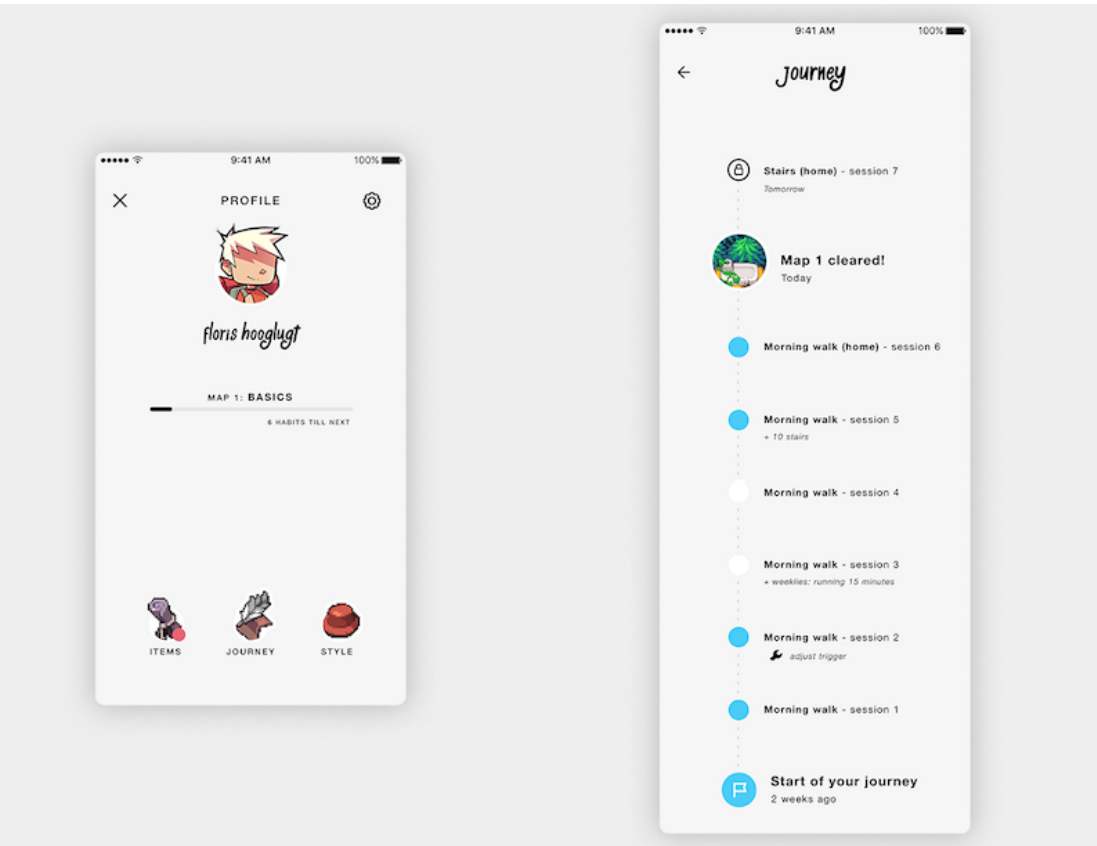
Figure 6. Two examples of the app MoveDaily as to how progress can be visualized: through a level indicator of the avatar (image on the left) and through a timeline showing all performed activities (image on the right).